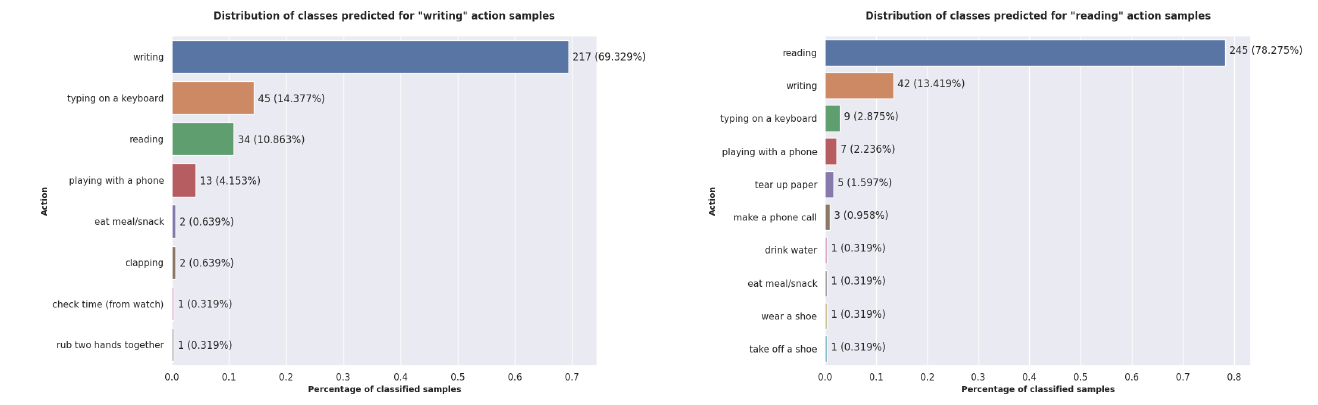
Figure 12. The distribution of the classes predicted by the proposed model for the writing and reading actions when using the Cross-View protocol. Table 9. Statistics for how people perceive similar actions by analyzing a graphical representation of skeletal